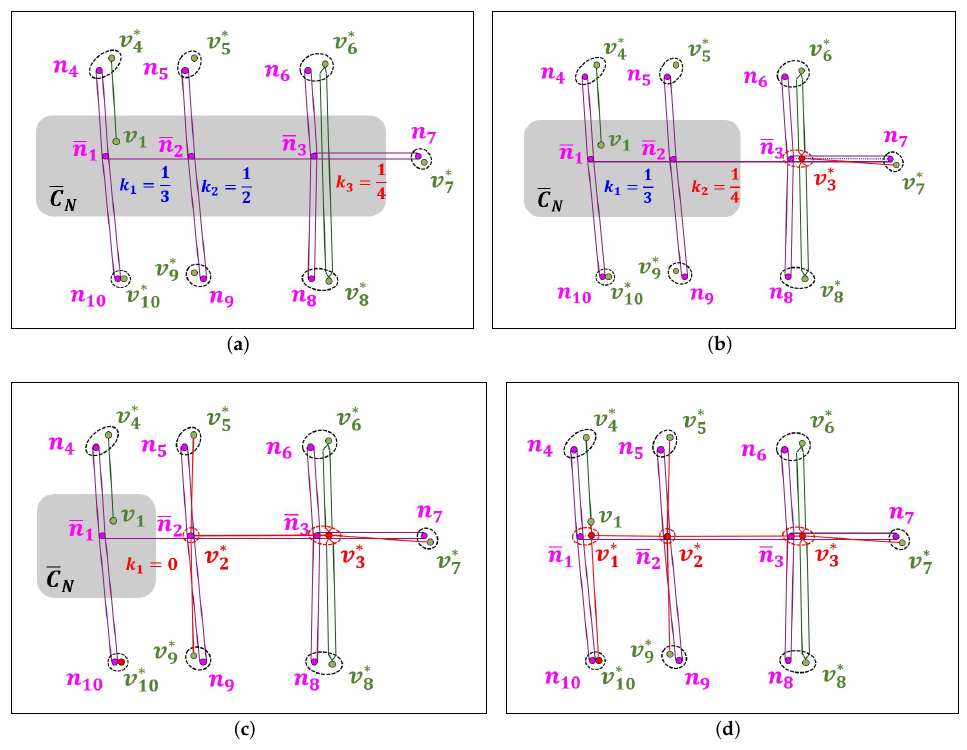
Figure 11. Example of SOSC scheme for unmatched NLM component C N : ( a ) Initial unmatched NLM component C N , ( b ) after the extraction of n 3 from Q , ( c ) after the extraction of n 2 from Q , and ( d ) the ORN subgraph G O ( C N ) for C N